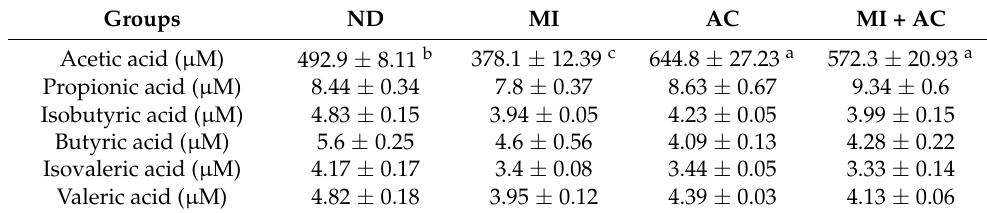
Table 2. Plasma SCFA levels in 12-week-old male offspring.